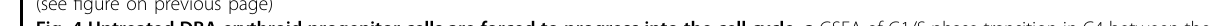
Fig. 4 Untreated DBA erythroid progenitor cells are forced to progress into the cell cycle. a GSEA of G1/S phase transition in C4 between the NC and UT, and the UT and GCR groups. b Beeswarm plot showing the expression of the G1/S phase transition gene set in C3 among the samples. c CDK1 expression in C3 is shown among groups. d GSEA of regulation of DNA replication between the NC and UT and the UT and GCR groups. e Beeswarm plot showing the expression of the DNA replication gene set in C3 among the samples. f The expression of CDT1 in C3 is shown among groups. g The fraction of cells in G1, S and G2/M in C3 among groups. h Heatmap representing normalized enrichment score (NES) from GSEA for comparison between the indicated groups in C3 cells at the S-phase of cell cycle; the colored rectangles indicate signi fi cant enrichment (namely, higher expression) of corresponding processes in the designated groups ( P < 0.05). i Immuno fl uorescence measuring DNA damage with γ H2AX expression in RPS19 -diminished primary erythroid cells on day 4 of differentiation with or without Dex treatment. j Quanti fi cation of immuno fl uorescent intensity of γ H2AX. The signal intensity of RPS19 - depleted cells was normalized to the scramble (Scr) control. k , l Western blot analysis showing the protein expression of RPS19 ( k ) and P53 ( l ) after lentiviral- mediated shRNA knockdown in erythroid cells derived from CB- CD34 + cells on day 8 of differentiation. α -tubulin serves as the loading control. n = 3 independent experiments. m Quanti fi cation of immuno fl uorescent intensity of γ H2AX in erythroid cells derived from CB-CD34 + cells on day 8 of differentiation. The signal intensity of each group ( RPS19 single, P53 single or their double depleted cells) was normalized to the corresponding control. For ( j and m ), results are presented as the mean ± SEM. P values were determined using Student ’ s t test, *** P < 0.001; * P < 0.05;ns, no statistical signi fi cance. n ≥ 3 independent experiments. For all the beeswarm plots ( b , c , e and f ), each dot represents the expression value for each single cell that was calculated by summing the log 2 transformed UMI of every gene within the gene set. Diamonds represent mean expression values for each cluster, and boxes represent the median and quartiles. P values were determined using Wilcoxon rank sum tests. **** P ≤ 0.0001, *** P ≤ 0.001 and ** P ≤ 0.01; ns, no signi fi cance. See also Supplementary Figs. S5,6 and Table